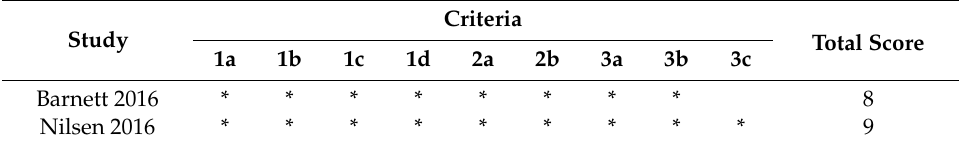
Table 3. Methodological quality assessment of included cohort